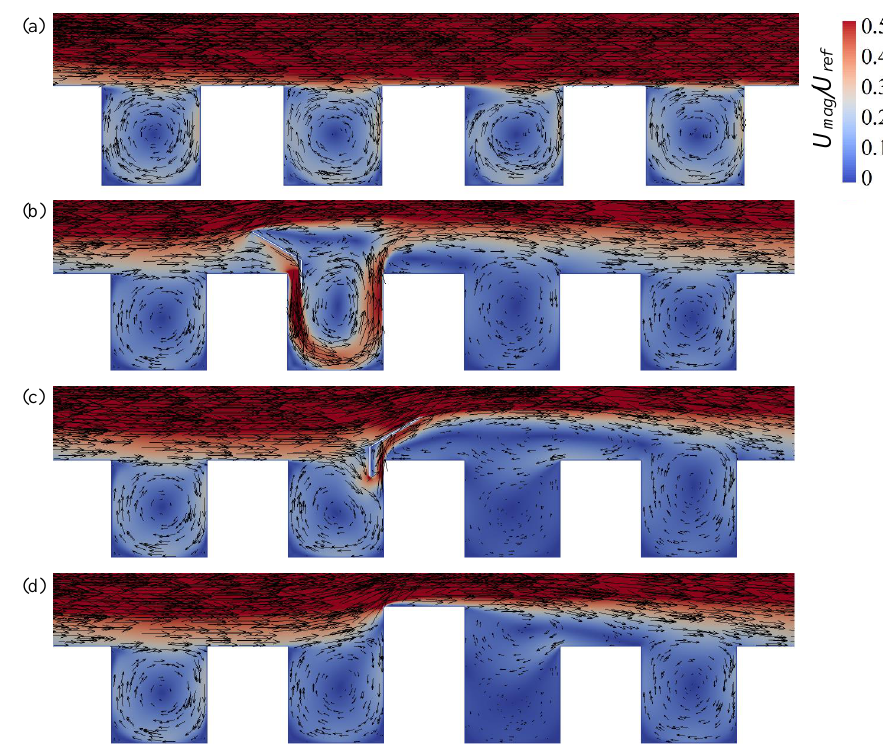
Figure 15. Normalized velocity magnitude contours and vectors in canyons 3–6 for cases: ( a ) reference case, ( b ) wind catcher, ( c ) reversed wind catcher, and ( d ) step-up/step-down canyons. The scale ranges from 0 to 0.5 (not 1.0) to emphasize the in-canyon